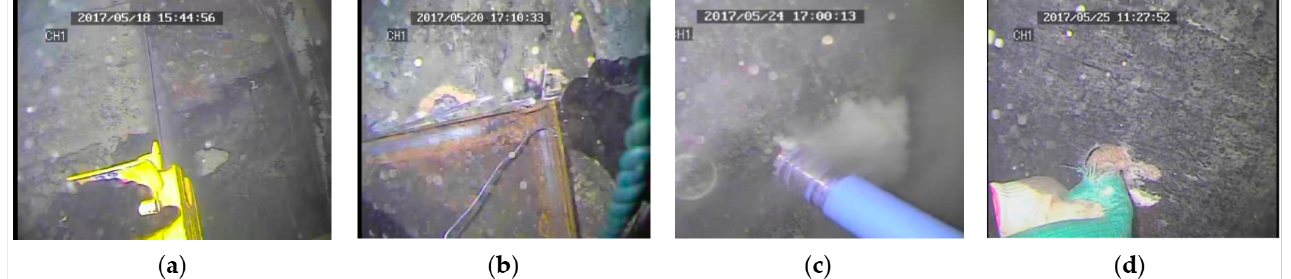
Figure 6. The construction process: ( a ) panel cutting; ( b ) die fixing; ( c ) construction panel drilling; ( d )